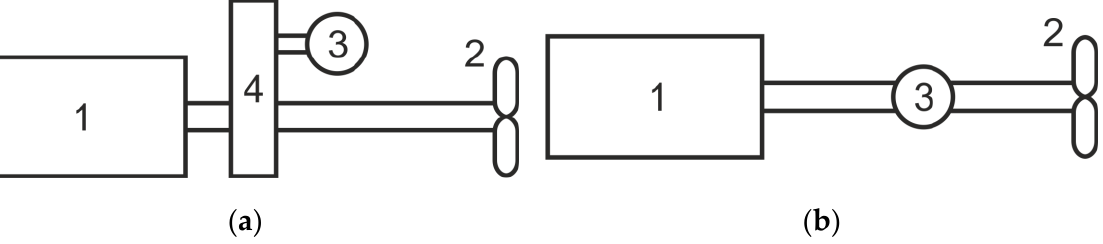
Figure 1. Ship propulsion with motion transmission for two types of mechanical power take-up: ( a ) connection of the shaft generator through a reducer to the propeller shaft (first type), ( b ) connection of the shaft generator directly to the propeller shaft (second type).